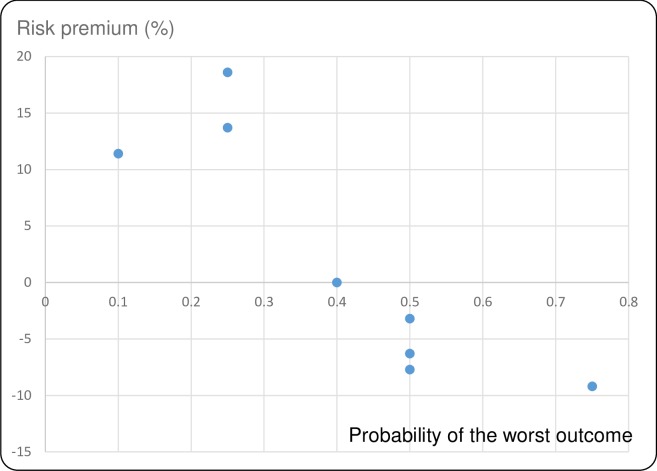
Risk premiums plotted against probability of the worst outcome in the losses lottery for timeliness.